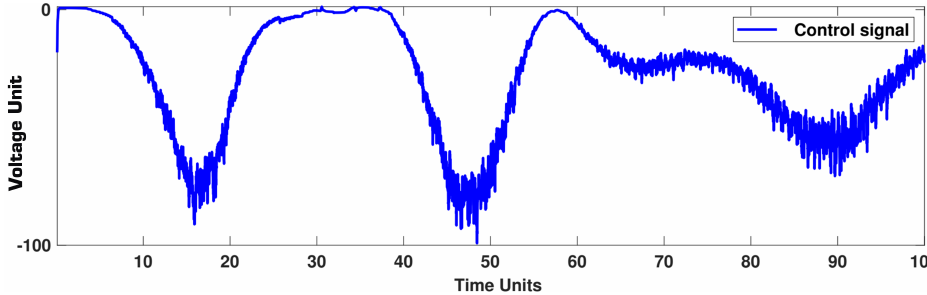
Figure 10. Example 2: Control signal, faulty